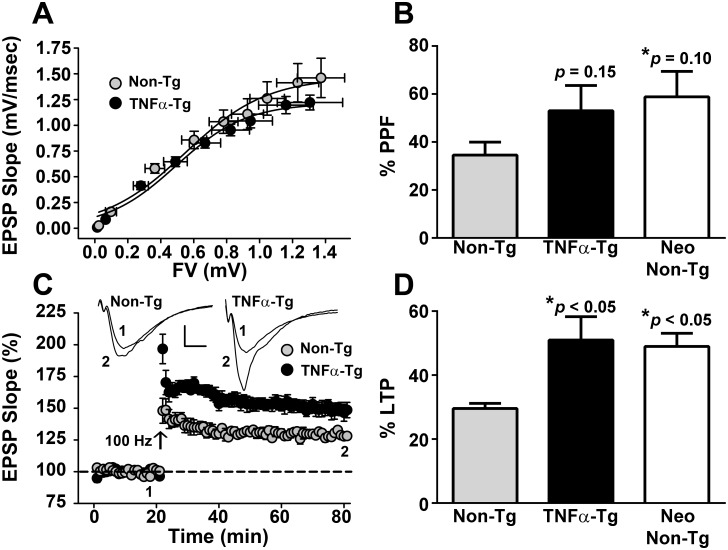
Measurement of CA3-CA1 synaptic function in hippocampal slices from TNFα-Tg and non-Tg rats.A, Mean ± SEM CA1 excitatory postsynaptic potentials (EPSPs) in slices from adult Non-Tg and TNFα-Tg rats (n = 6-8/group) plotted against the CA3 fiber volley (FV) amplitude generated from nine successively increasing stimulus intensities. The maximal EPSP slope was slightly, though insignificantly, increased in non-Tg hippocampus. B, Mean ± SEM paired-pulse facilitation (PPF) of the EPSP is shown in response to twin stimulus pulses administered with a 50 ms inter-pulse interval. Non-Tg neonatal (Neo) rats (2–3 weeks-old, n = 5) are shown for comparison. PPF was greater (albeit, nonsignificantly) in TNFα-Tg rats and Non-Tg neonatal rats relative to Non-Tg adult rats (p > 0.05). C, Time plot showing normalized mean ± SEM EPSP slope amplitudes in slices from adult Non-Tg and TNFα-Tg rats (n = 6-8/group) before and after the delivery of two 100-Hz trains (arrow) to induce LTP. Inset shows representative EPSP waveforms averaged during the last 10 minutes of the pre-LTP (1) and post-LTP (2) baselines (calibration bars, 0.5 mV/5 ms). D, Mean ± SEM LTP measured 60 min after the delivery of 100 Hz stimulation. Non-Tg neonatal (Neo) rats (2–3 weeks-old, n = 5) are shown for comparison. LTP was significantly elevated in TNFα-Tg rats and Non-Tg neonatal rats relative to Non-Tg adult rats.